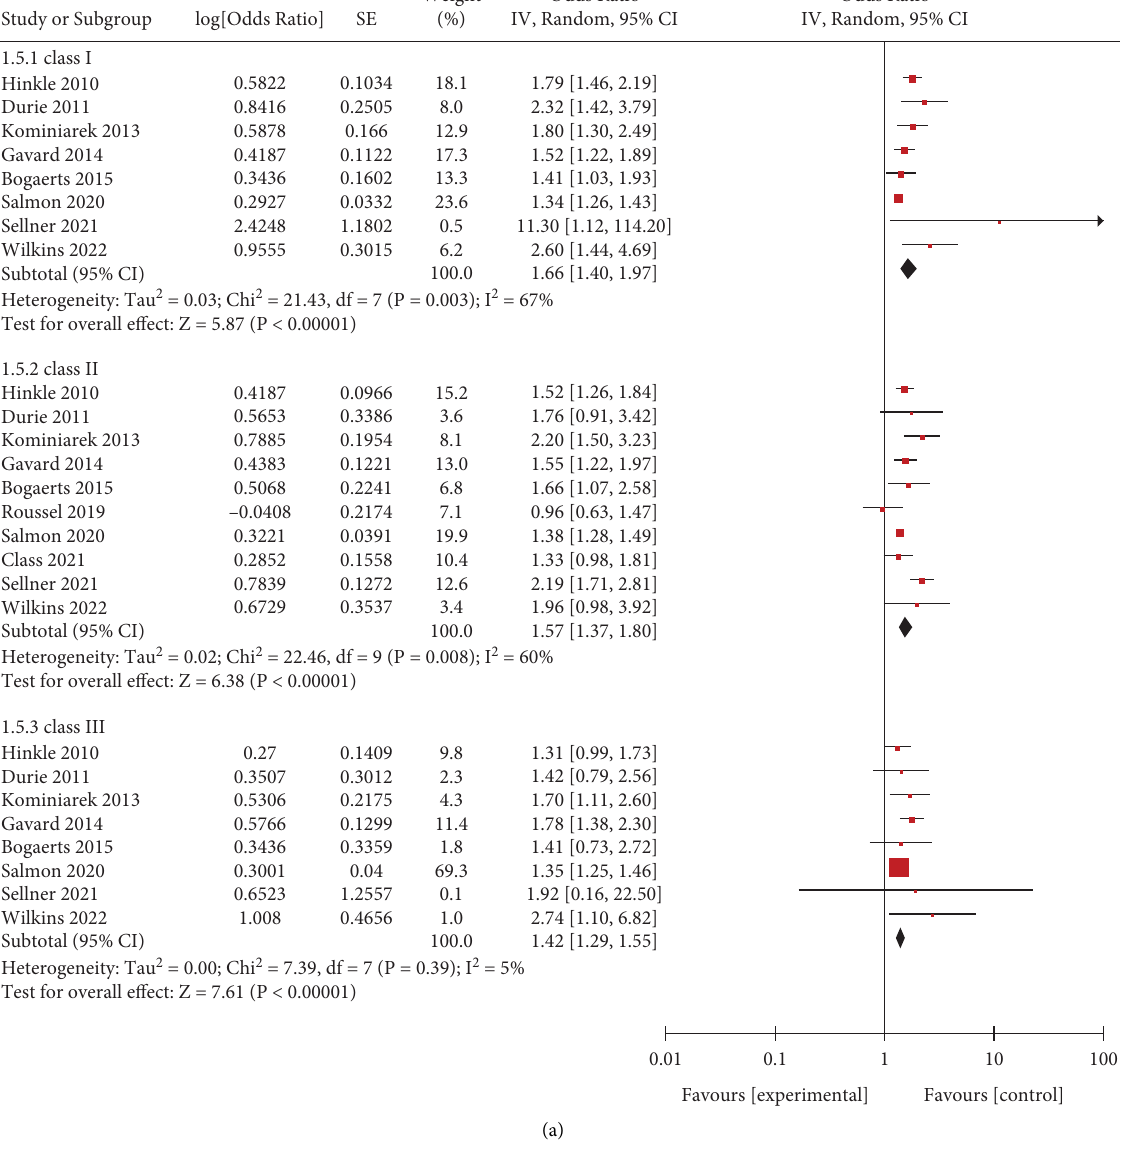
Heterogeneity: Tau 2 = 0.00; Chi 2 = 7.39, df = 7 (P = 0.39); I 2 = 5% Test for overall efect: Z = 7.61 (P <